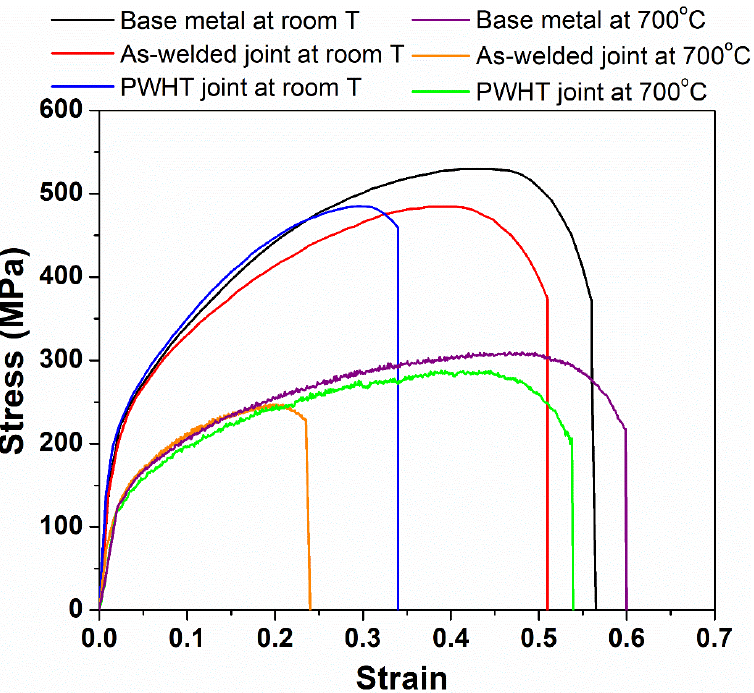
Figure 7. Typical tensile curves of the base metal, as-welded, and PWHT friction welded joints at room temperature and at 700 °C.